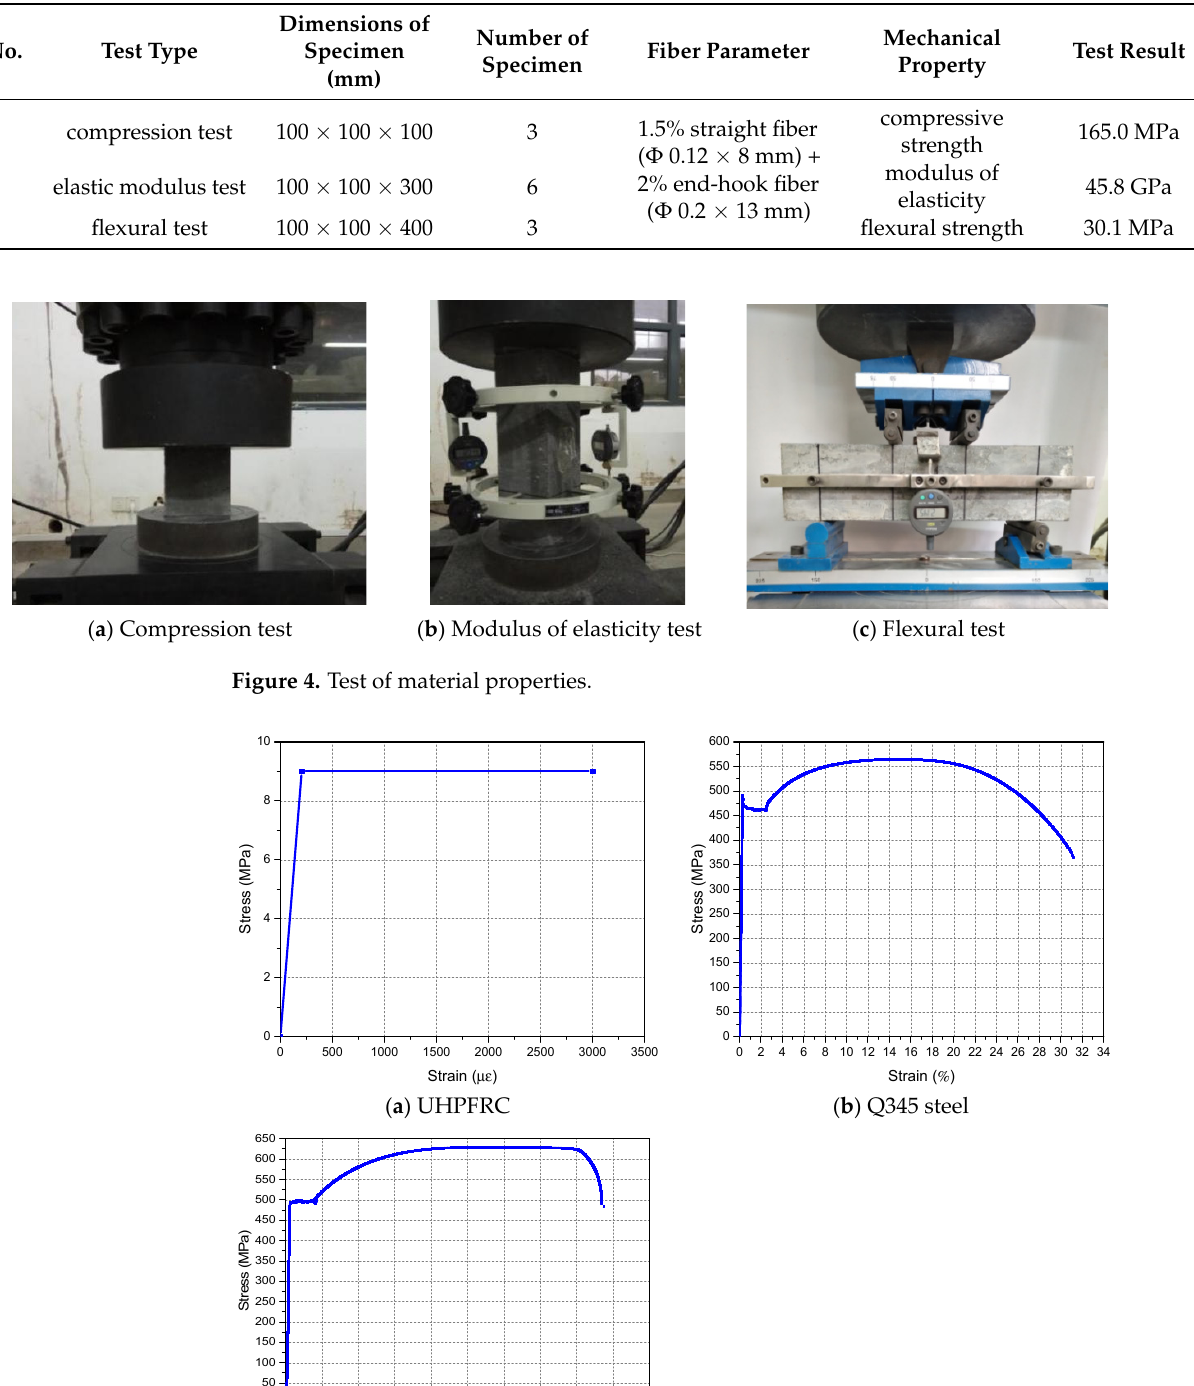
Table 3. Mechanical properties of UHPFRC.